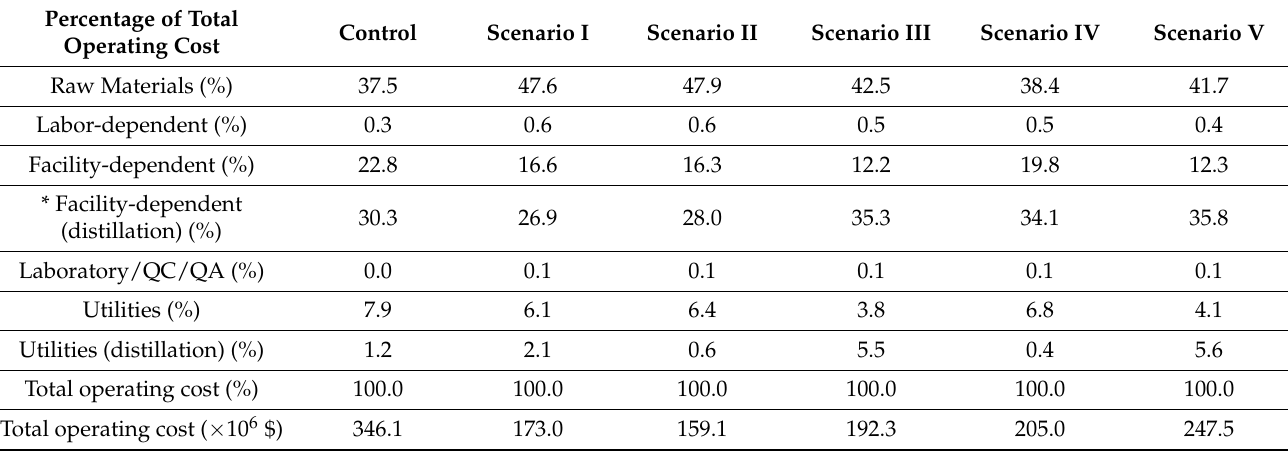
Table 10. Production cost parameters for 2,3-BD fermentation with distillation.